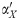
Association was detected in 25 out of 25 datasets with underlying association in the high Pearson correlation coefficient (>0.63) group: The figure is arranged in exactly the same way as Fig 5.BPA for combinations of various αX′ and αY′ are shown as a heatmap for 9 datasets. Below every heatmap, a scatterplot of the actual data is shown. Also, a black line shows the relationship function that was calculated by curve fitting approaches. On the top left of the heatmap, the unique index of every dataset is presented. On the top of the heatmap Pearson correlation coefficient (PC) along with the p-value in brackets and the normalized mutual information content (MI) for the dataset is given. On the top of the scatterplot, the Spearman rank correlation coefficient (SR) and the Kendall tau rank correlation coefficient (KT) are given.